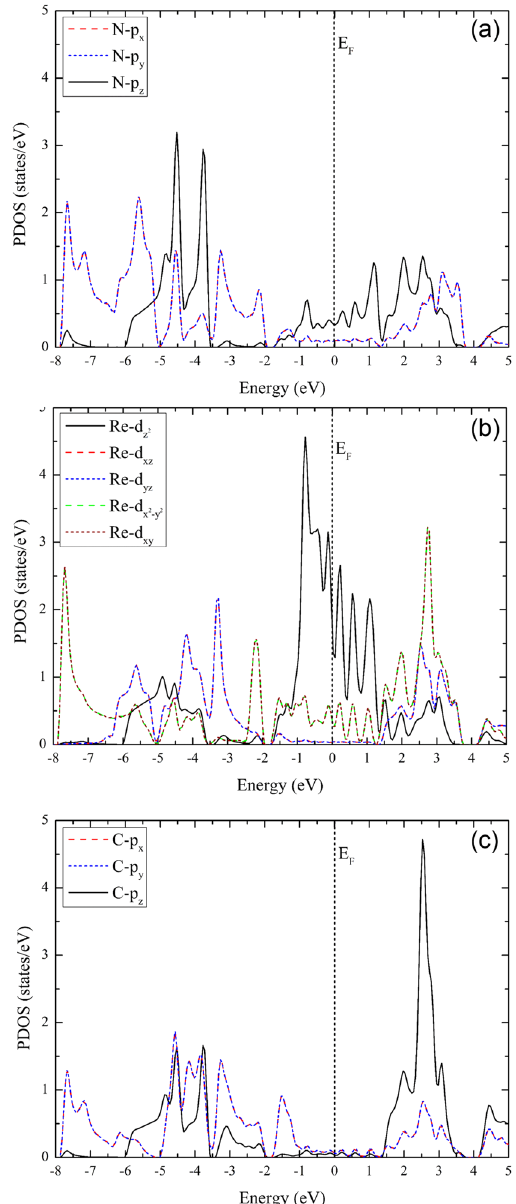
Figure 9. Orbital resolved partial density of states for: ( a ) N-p orbitals, ( b ) Re-d orbitals, and ( c ) C-p orbitals. The reference energy is the Fermi